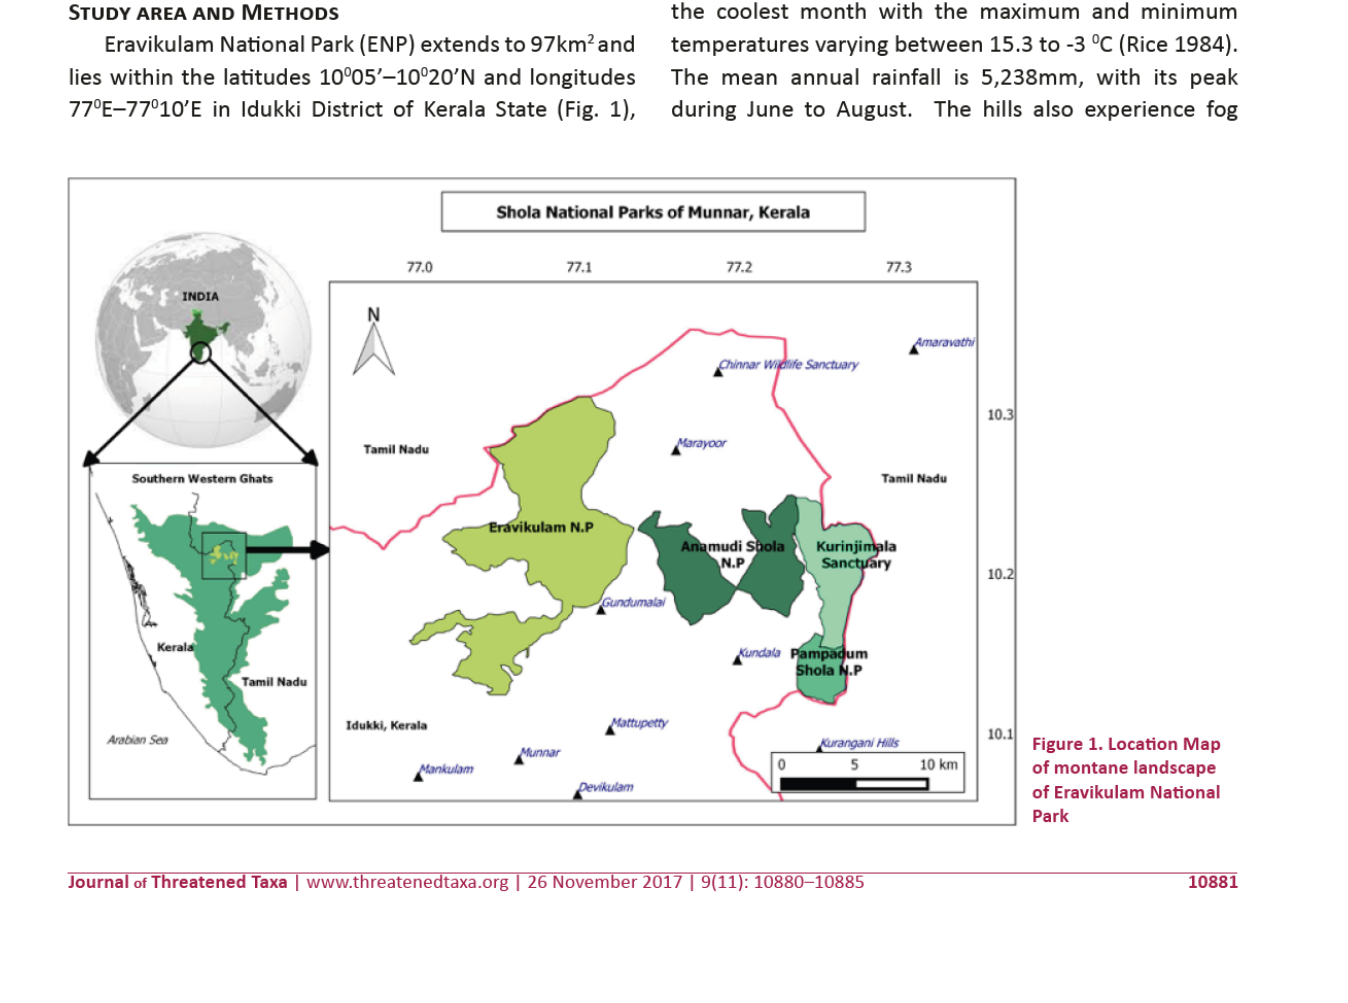
Ffigure 1. Locafion Map off montane